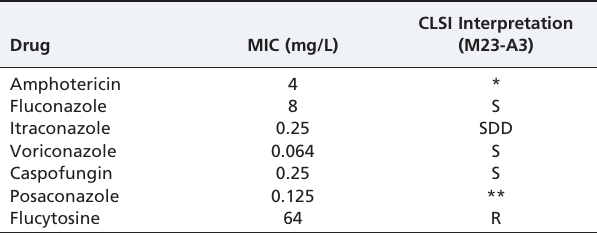
Table 2 - Antifungal susceptibility profile of